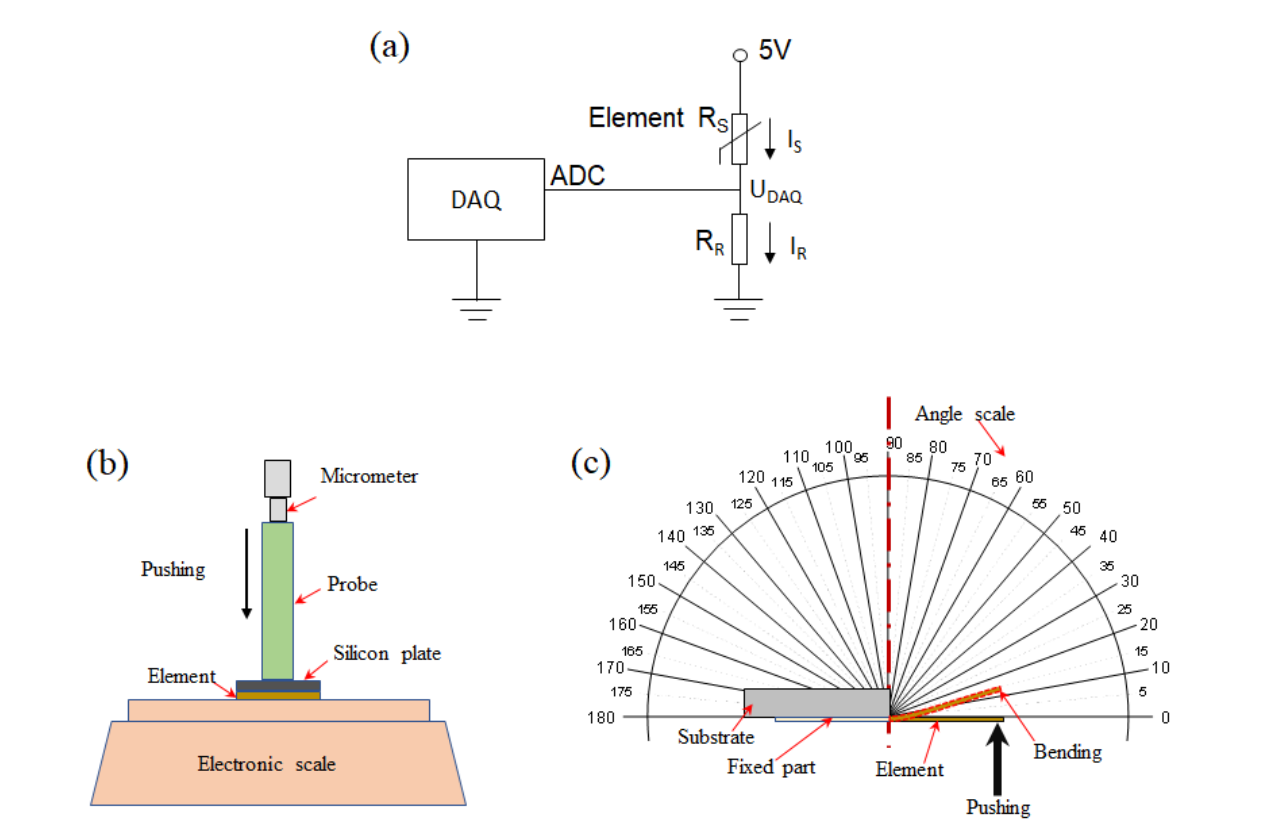
Figure 3. ( a ) Schematic of the electrical measurement circuit. ( b ) Pressure loading mode for the piezoresistive element. ( c ) Bending loading mode for the piezoresistive element.